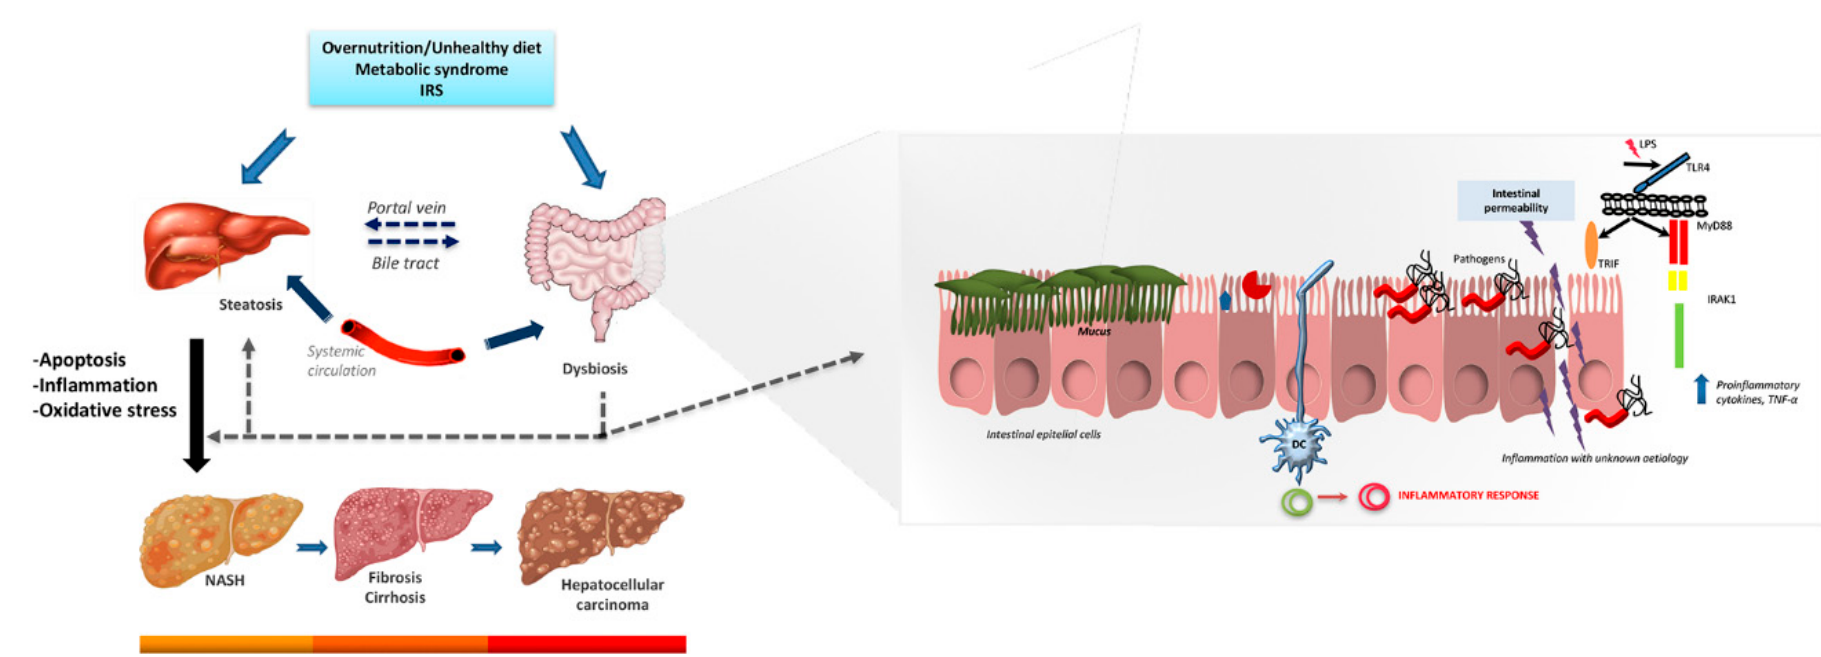
Figure 1. Impact of gut microbiota in hepatic disease. Schematic representation of the main factors involved in the development of NAFLD and the influence of gut microbiota and intestinal permeability through the gut-liver axis. Abbreviations: DC, dendritic cells; IRAK-4; Interleukin 1 Receptor Associated Kinase 4; IRS, insulin resistance syndrome; LPS, lipopolysaccharide; MyD88, Myeloid differentiation primary response 8; NAFLD, Non-alcoholic fatty liver disease; NASH, Nonalcoholic steatohepatitis; TLR4, toll-like receptor; TNF- α , Tumor Necrosis Factor alpha; TRIF, TIR-domain-containing adapter-inducing interferon- β .